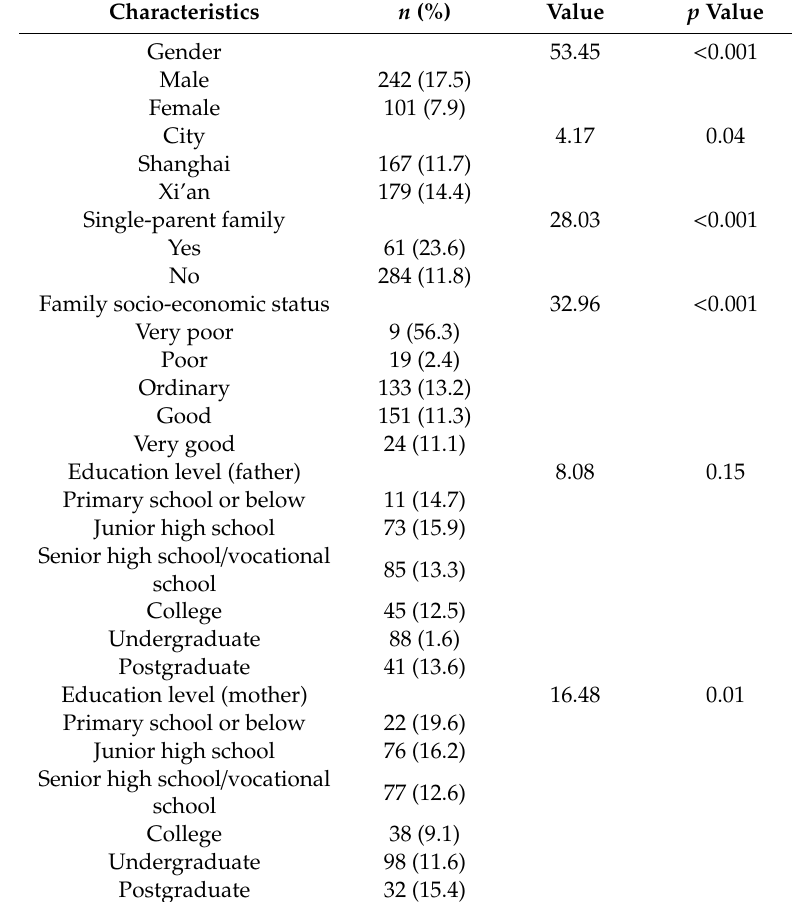
Table 2. The prevalence of Internet gaming disorder (IGD) and its Chi-square test in adolescents with di ff erent